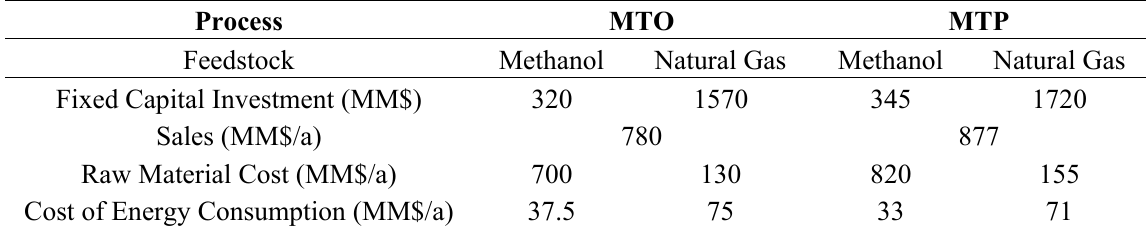
Figure 5. Flowsheet for the MTP process. Table 2. Overview of the key economic